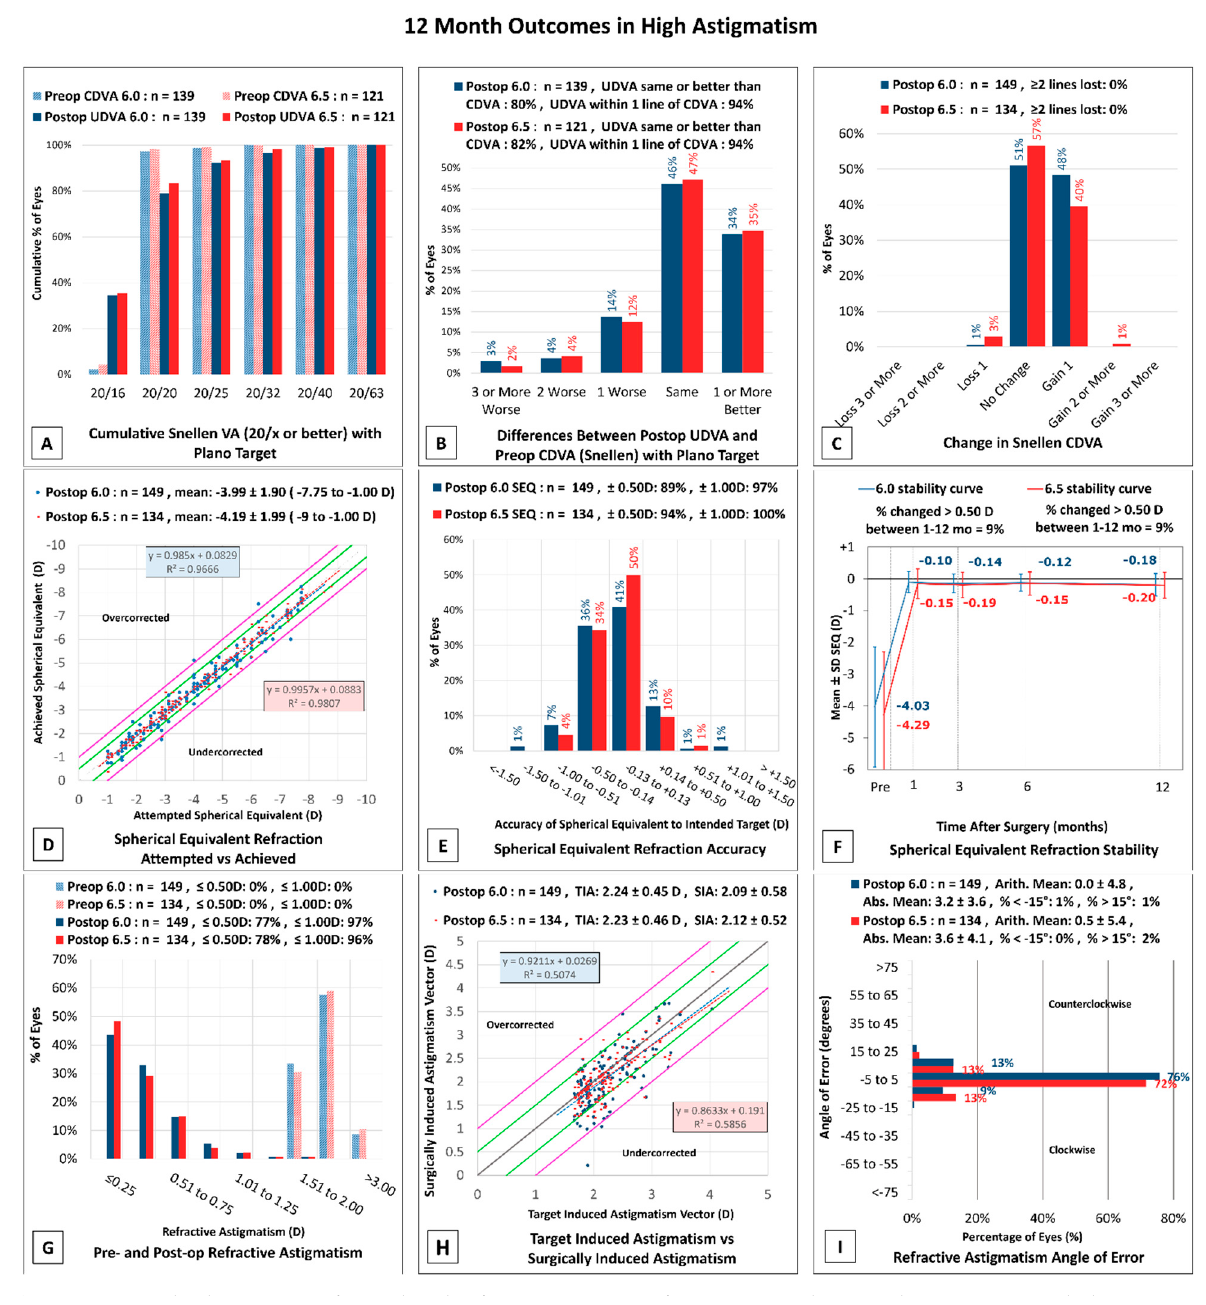
Figure A5. Standard reporting of visual and refractive outcomes for eyes at twelve months postoperatively between 6.0 and 6.5 mm in High Astigmatism. ( A ) Cumulative preoperative CDVA and postoperative UDVA; ( B ) difference between preoperative CDVA and postoperative UDVA; ( C ) change in Snellen CDVA; ( D ) attempted vs. achieved MRSE; ( E ) accuracy of MRSE; ( F ) MRSE stability at one, three, six, and 12 months; ( G ) comparison of preoperative and postoperative manifest cylinder; ( H ) target-induced vs. surgically-induced astigmatism; ( I ) angle of error.